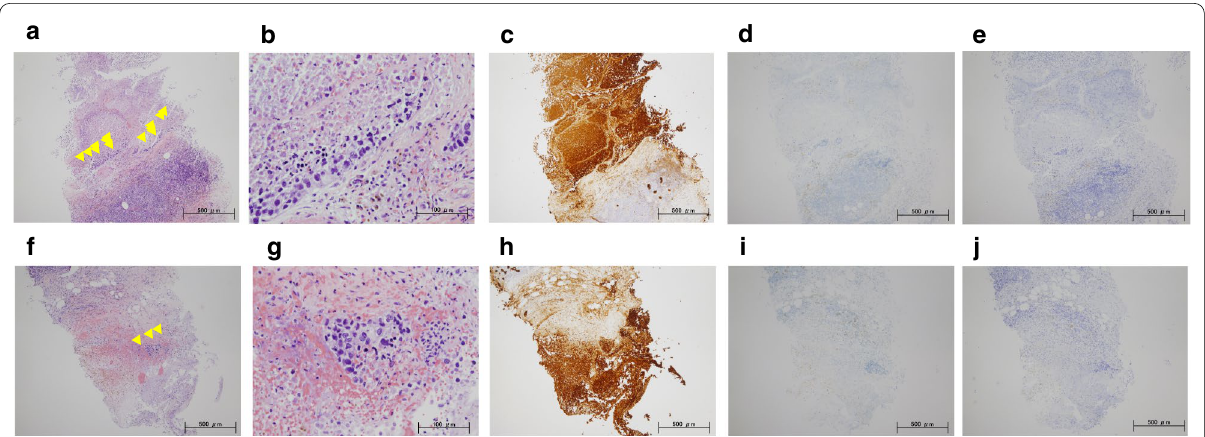
Fig. 2 Preoperative pathorological findings. The histopathological findings of the right breast from core needle biopsy ( a , f : hematoxylin and eosin (HE) 40; b , g : HE 200). Immunohistochemistry study for AE1/AE3, estrogen receptor (ER), and HER2 ( c , h : AE1/AE3 × × HER2 40). Small foci of atypical ductal cells are recognized (yellow arrow). Partial coagulation necrosis is generated in estrogen receptor-negative, × HER2-negative, and AE1/AE3-positive ductal carcinoma without infiltration of lymphocytes